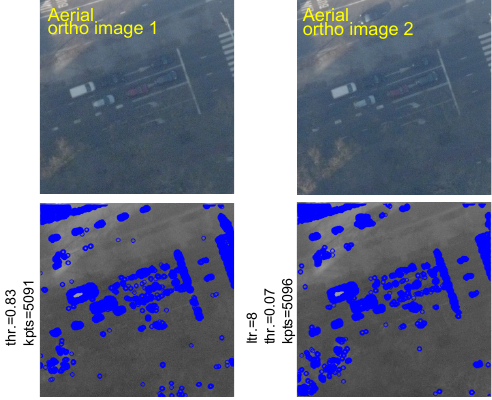
Figure 8. Adaptive approach for different aerial images of the same scene. The underlying image differences can be realized by comparing the threshold, iterations and the obtained